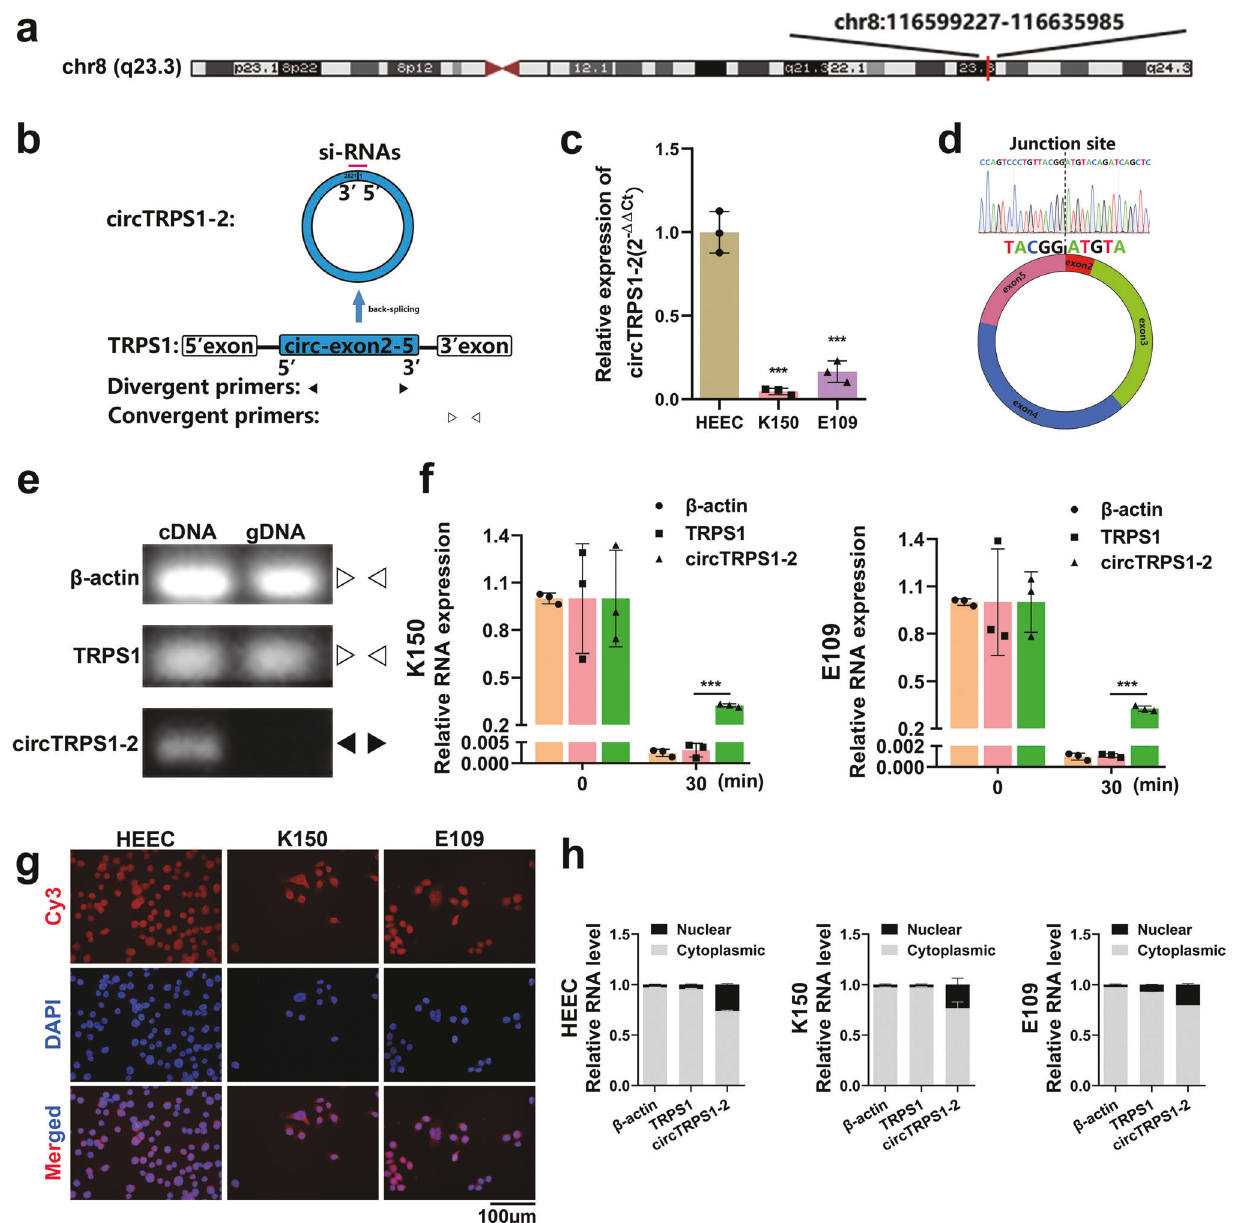
Fig. 2 Characterization and subcellular localization of circTRPS1-2 in ESCC tissues. a Chromosomal location of circTRPS1-2, as determined using the UCSC Genome Browser. b Schematic of the biogenesis of circTRPS1-2. Locations of the forward and reverse primers for ampli fi cation of circTRPS1-2 and linear TRPS1, as well as the locations of the siRNAs targeting circTRPS1-2. c Expression of circTRPS1-2 in HEECs and two ESCC cell lines. Results are from three independent experiments. d Sanger sequencing con fi rming the back-spliced sequence. e Detection of circTRPS1-2 in cDNA but not genomic DNA, based on agarose gel electrophoresis. f Levels of circTRPS1-2 and linear TRPS1 in total RNA from K150 or E109 cells before (0 min) and after (30 min) RNase R treatment, as determined by qRT – PCR. Results are from three independent experiments. g FISH to determine the subcellular localization of circTRPS1-2 in HEECs and ESCC cells. Magni fi cation, 400×. Scale bar, 100 µm. h Nuclear-cytoplasmic fractionation to determine the subcellular localization of circTRPS1-2. Results are from three independent experiments. β -actin was the reference gene. Data are mean ± SD. * P < 0.05, ** P < 0.01, *** P < 0.001. FISH, fl uorescence in situ hybridization; HEEC, healthy human esophageal epithelial cells; qRT – PCR, quantitative real-time PCR; siRNA, short interfering